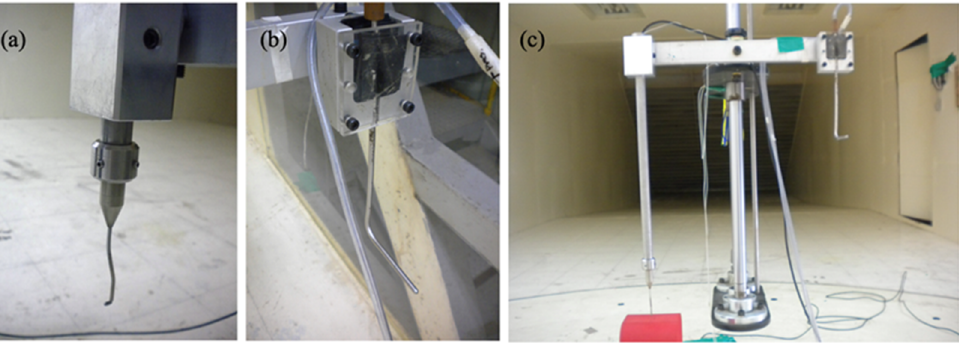
Figure 5. The measurement tools for building models in a wind tunnel are ( a ) cobra probes, ( b ) pitot tubes. ( c ) A demonstration on how to arrange the tools in a wind tunnel.